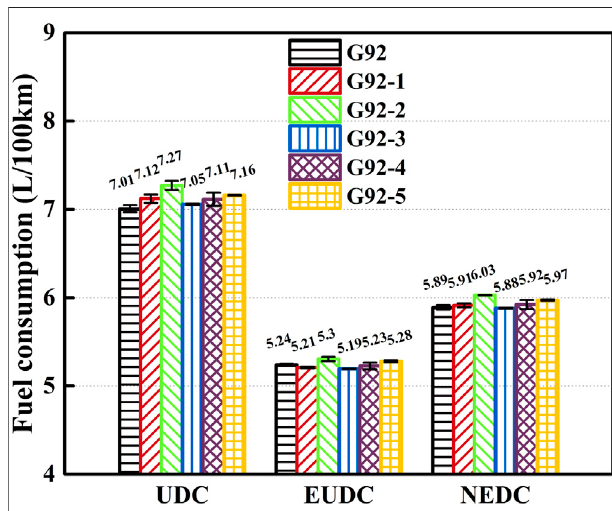
FIGURE 2 | Effects of different additives on fuel consumption of the vehicle.